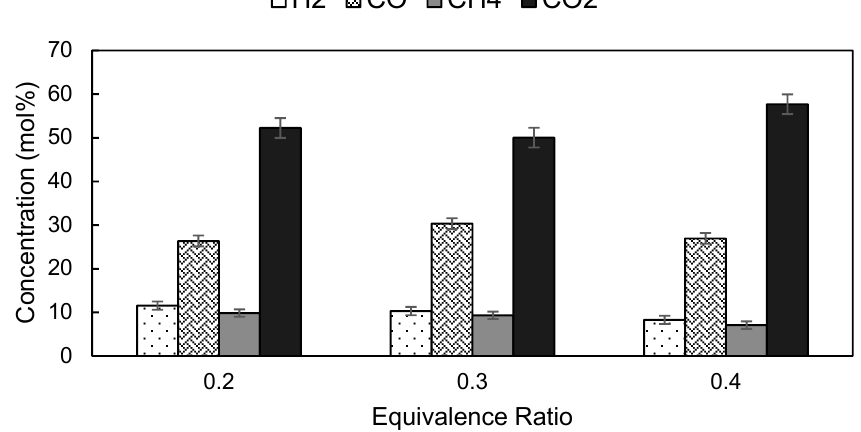
Figure 4. Effect of ER on the composition of producer gas produced from the gasification of Napier grass at a temperature of 850 ° C.